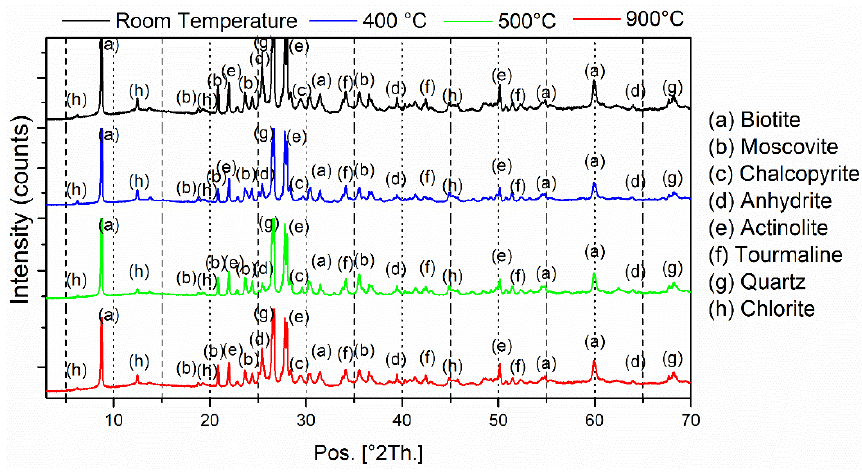
Figure 8. X-ray diffractograms of ore samples at room temperature and heated to 400, 500, and 900 °C.